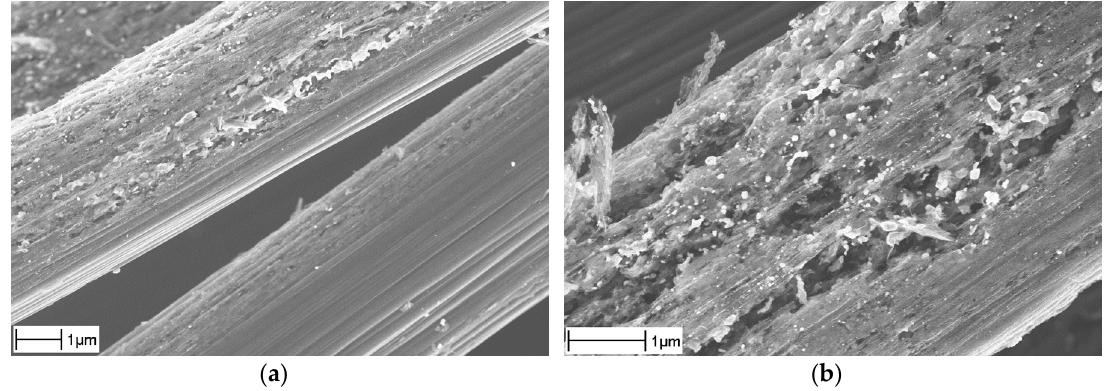
Figure 11. SEM images of eroded fibers, after acetone solution: smaller ( a ) and larger ( b ) magnifications.